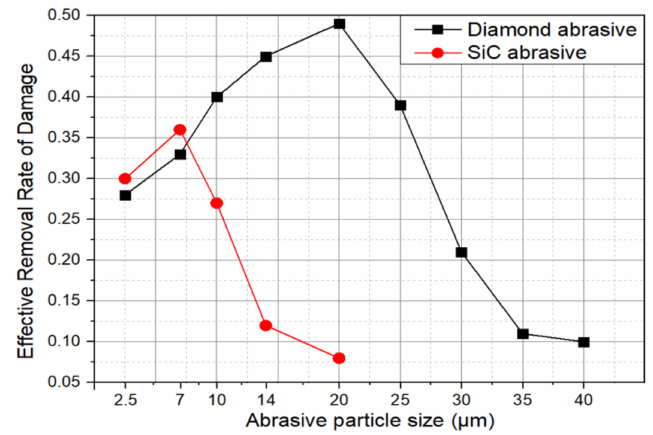
Figure 4. The relationship between e ff ective removal rate of damage (ERRD) and